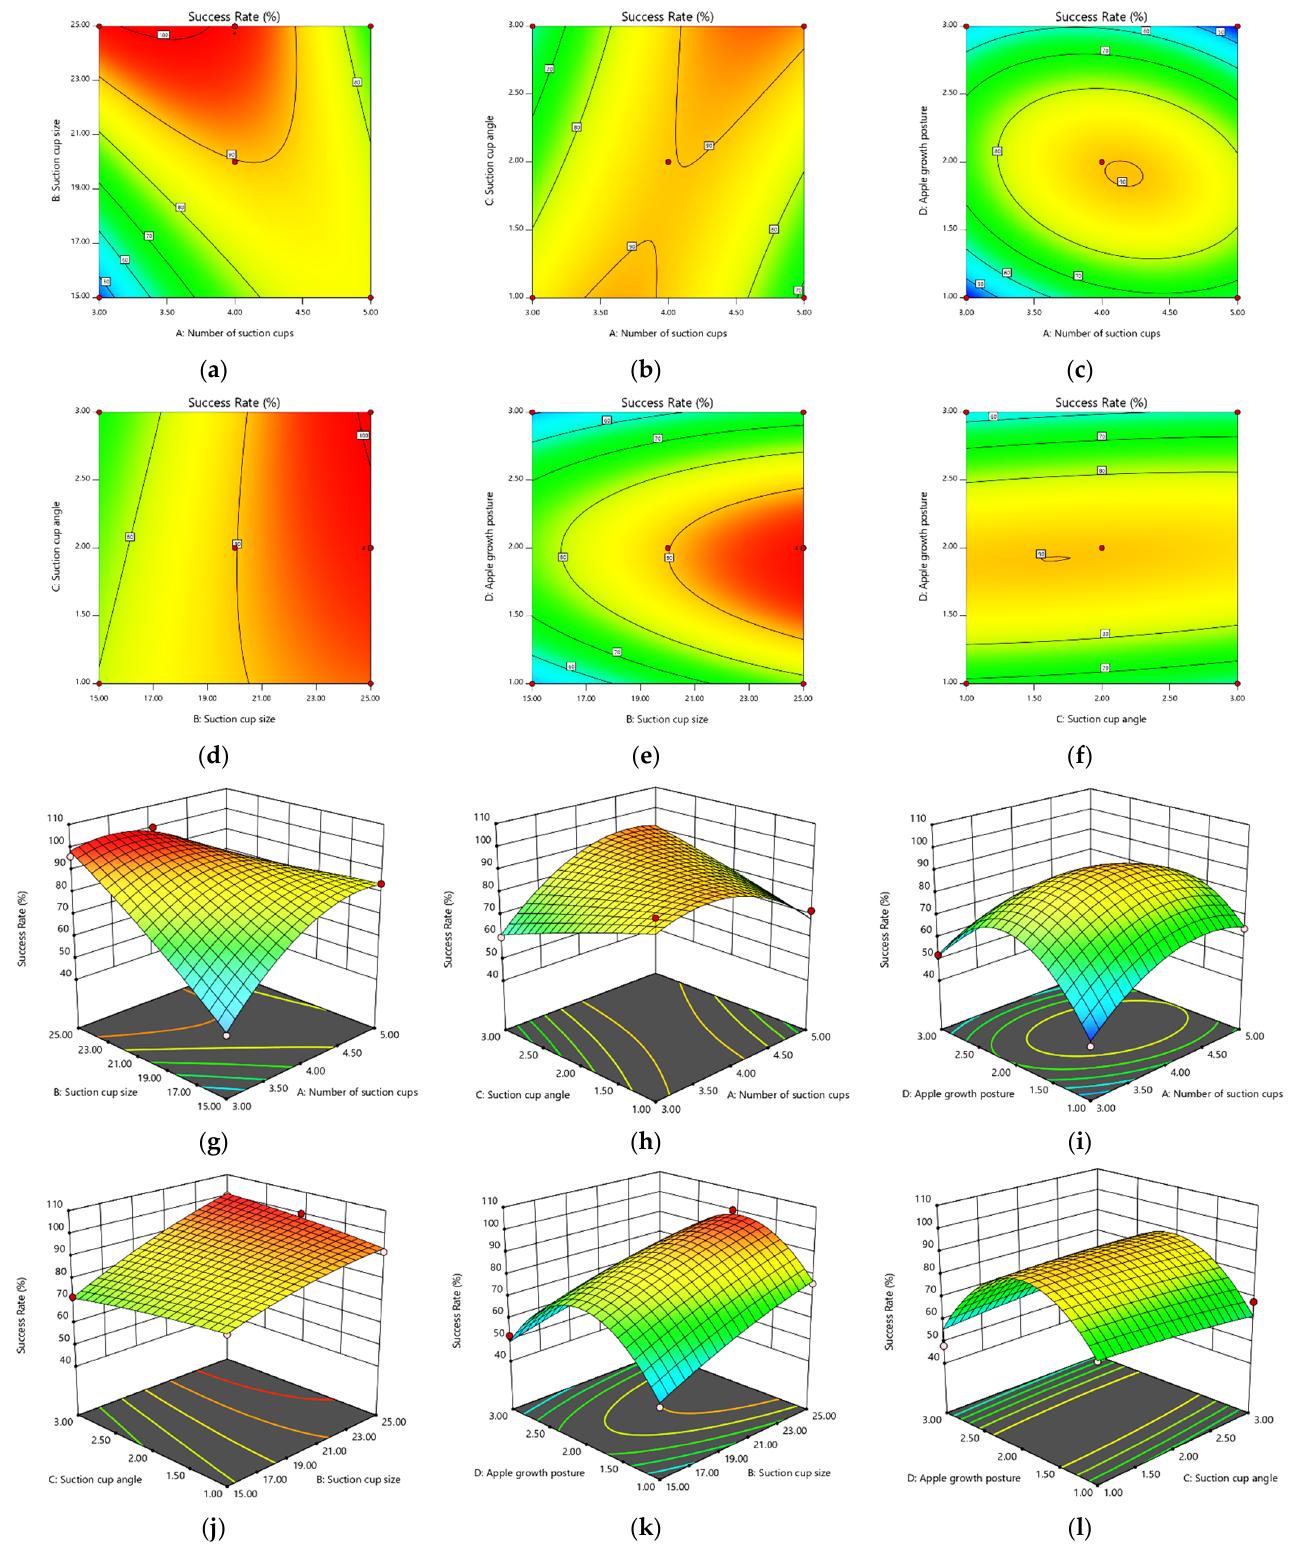
Figure 34. The interactions between the number of suction cups, suction cup diameter, suction cup angle and apple growth posture: ( a – f ) 2D contours; ( g – l ) 3D surface plots.